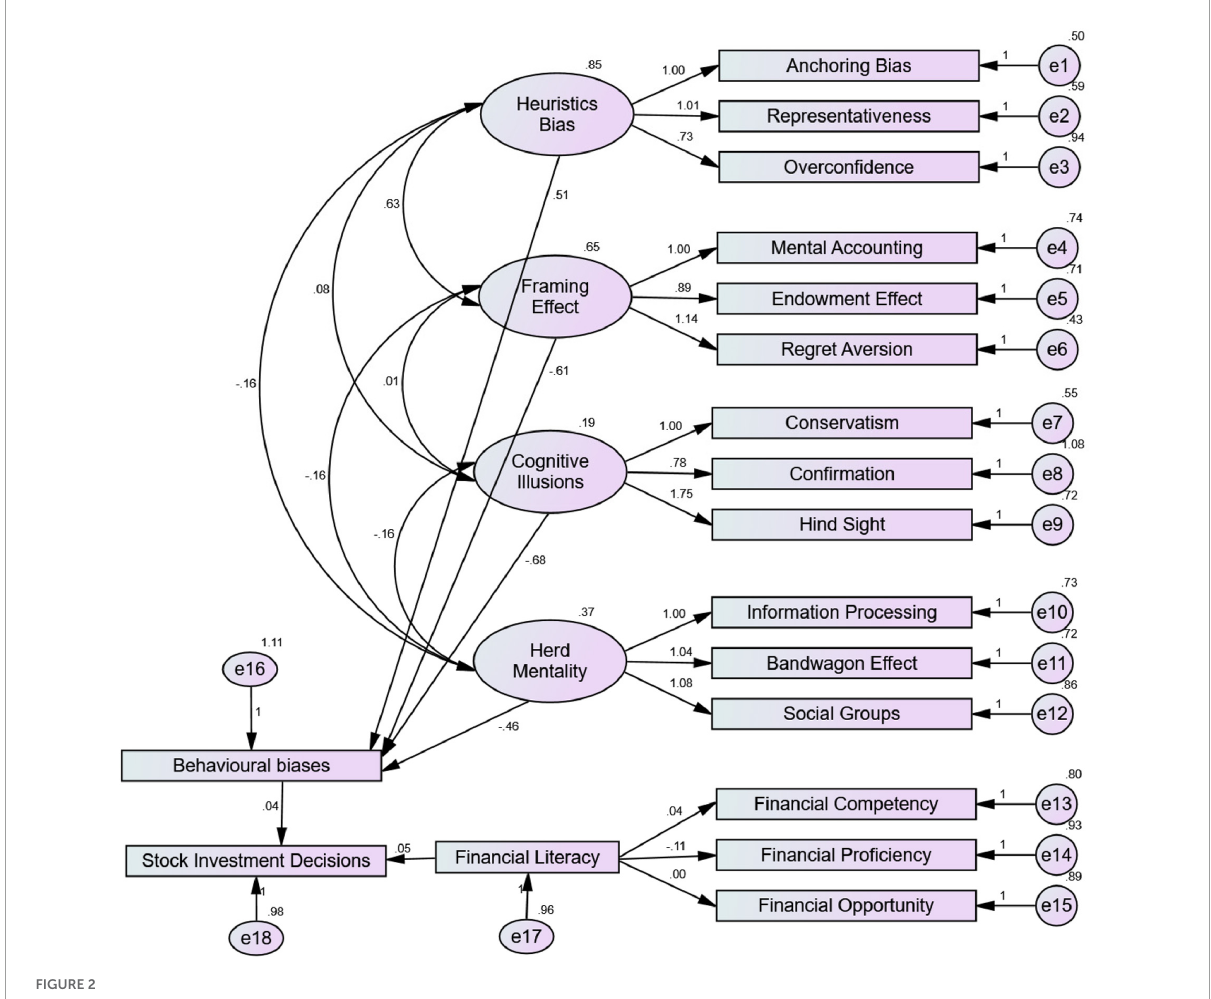
FIGURE2 Structural equation modeling.